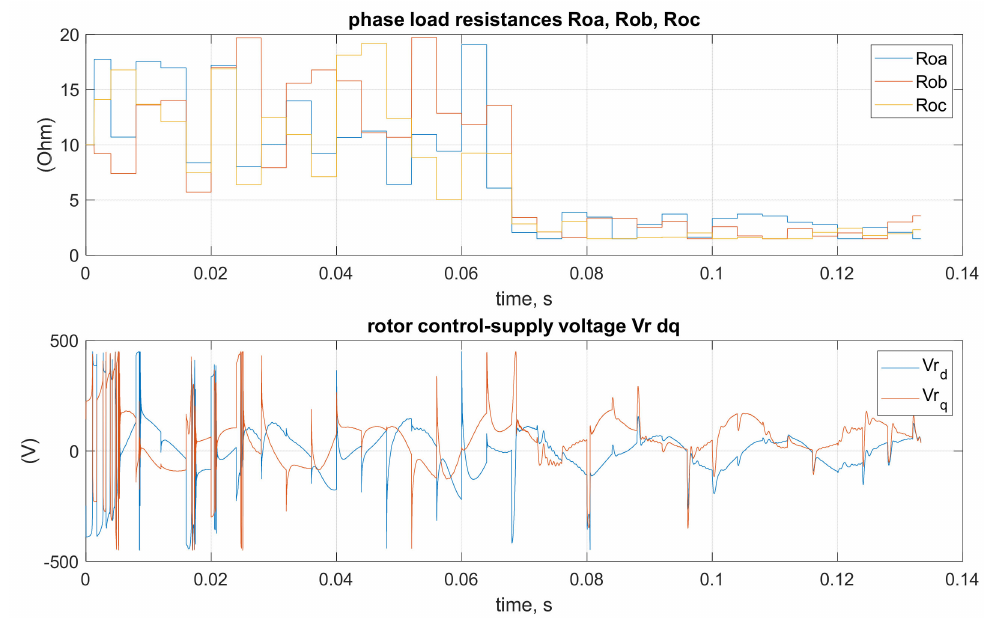
Figure 21. Rotor control voltage V r in the dq system, with limitations on control and with changes in the load as presented in Figure